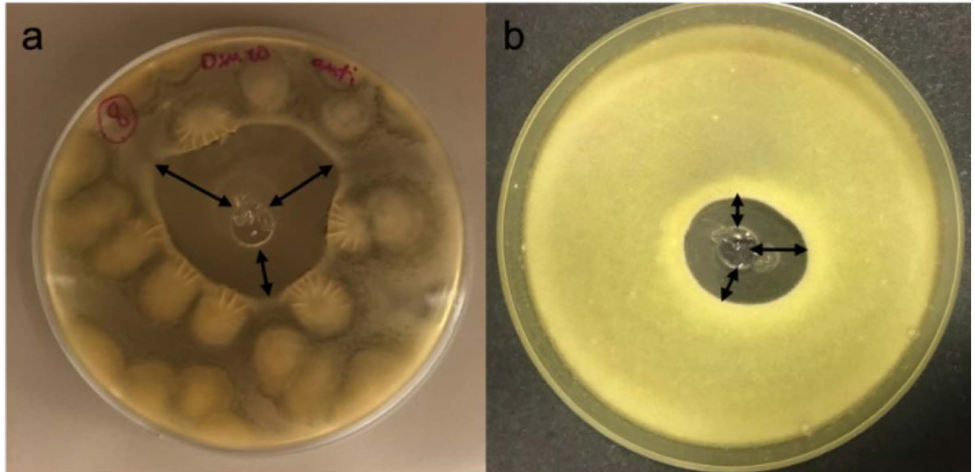
Figure 1. Schematic view of the measurement of inhibition of fungal mycelial growth. Three different inhibition rings (mm IR) were measured for each plate considered, as illustrated with black double arrows. ( a ) Botrytis cinerea ; ( b ) Alternaria alternata